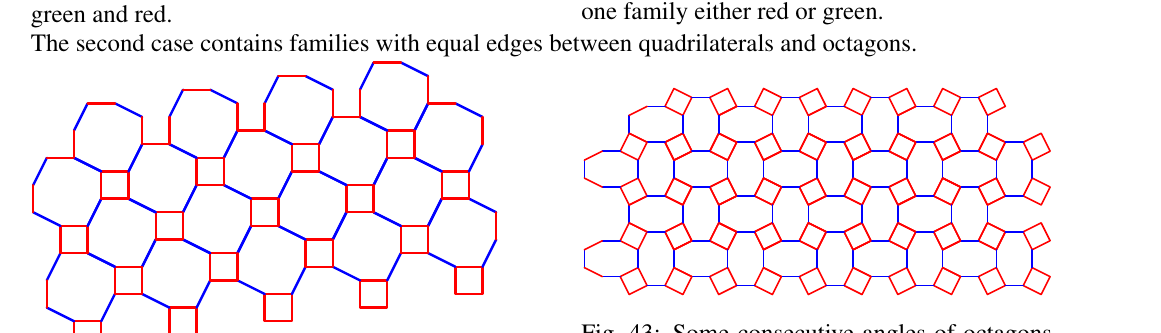
Fig. 43: Some consecutive angles of octagons are equal.